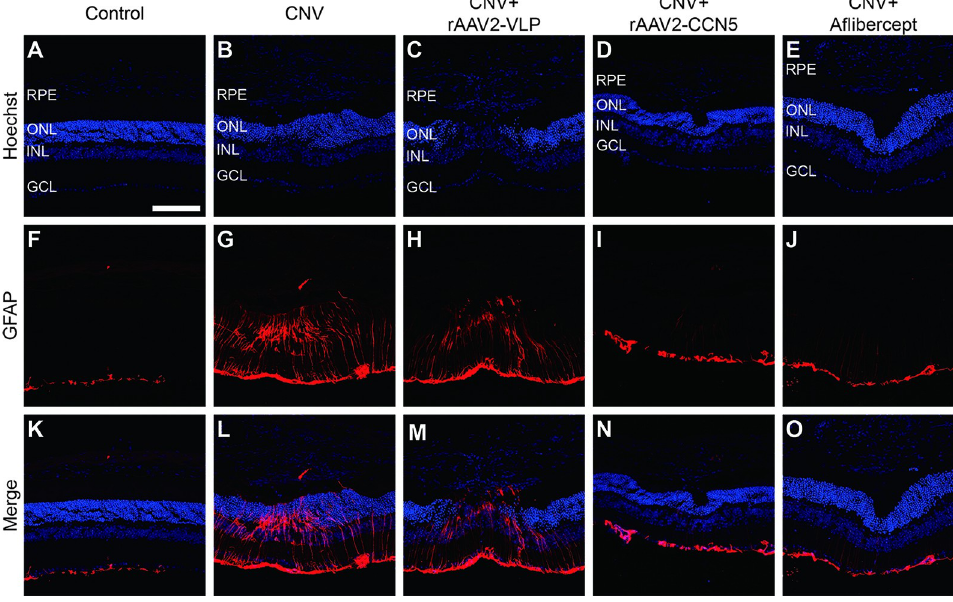
Fig 4. Assessment of retinal gliosis by immunostaining for GFAP. (A-O). Transverse retinal sections were immunostained for GFAP. Hoechst dye was used for staining of nuclei. RPE, retinal pigmeted epithelium; ONL, outer nuclear layer; INL, inner nuclear layer; GCL, ganglion cell layer. Scale bar, 100 μ m.